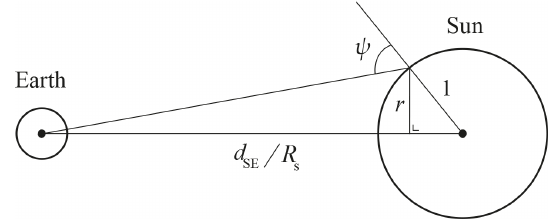
Figure 4. Definition of the heliocentric angle ψ used in Eq. (5) (not to scale). Distance d SE is the geocentric Earth–Sun distance, and r is the apparent distance on the solar disc from the solar disc centre. All dimensions are per solar radius R s . We neglect the effect of the sphericity of the Sun on the apparent solar disc radius, such that r = 1 for ψ = 90 ◦ .